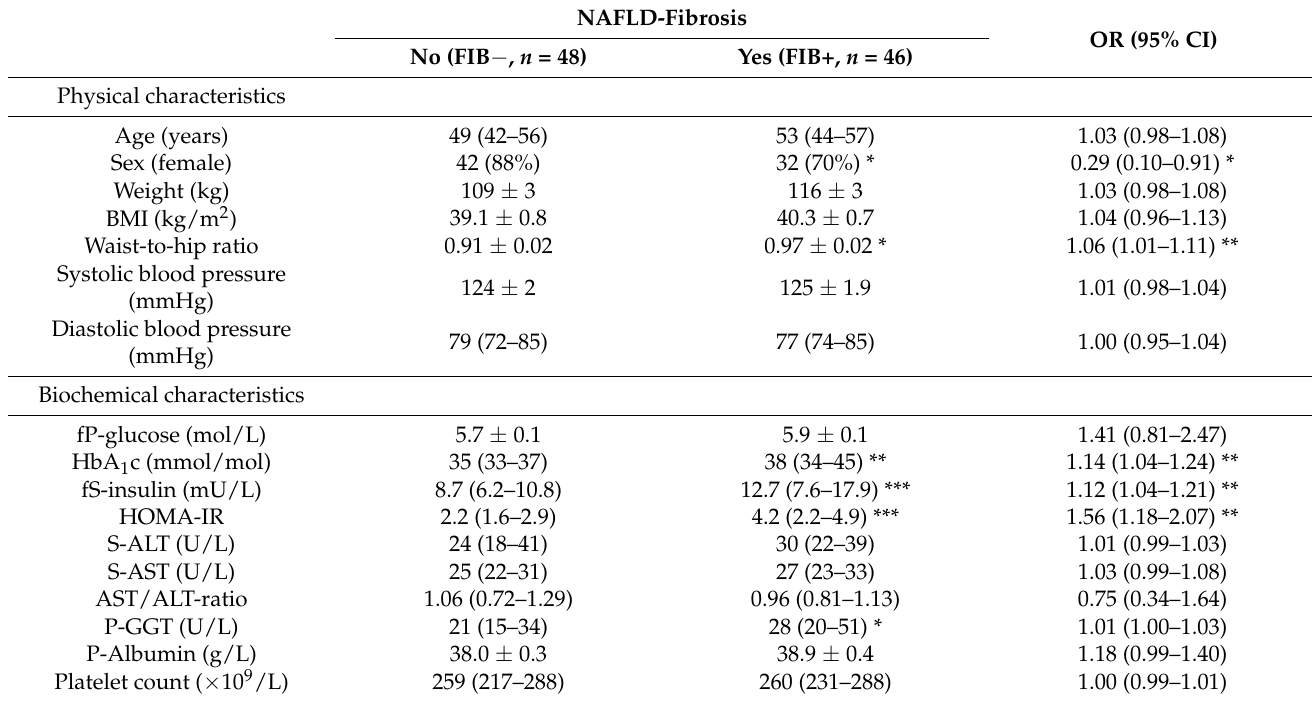
Table 2. Physical and biochemical characteristics, liver histology, and genetic characteristics of the participants without (FIB − ) and with (FIB+) NAFLD-fibrosis, and univariable analysis to predict